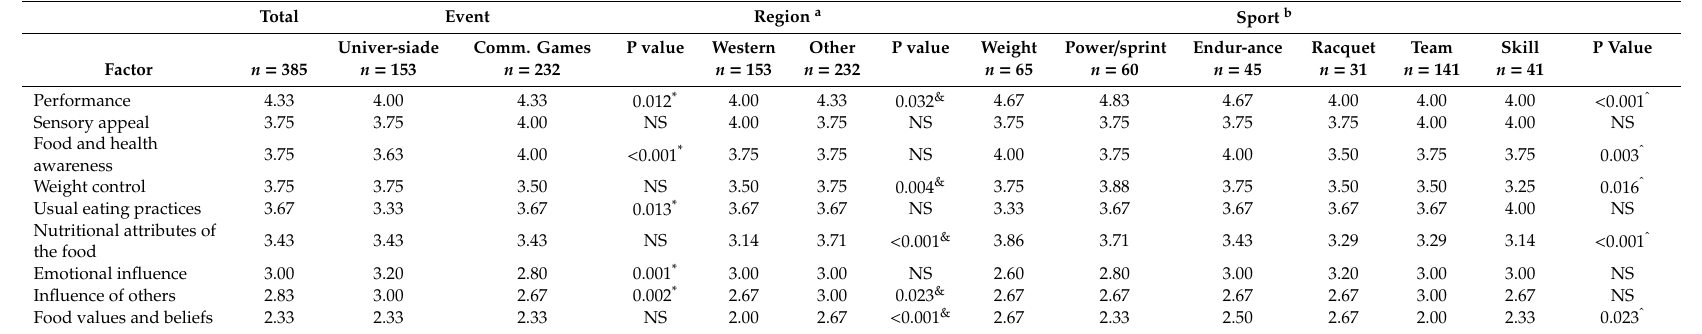
Table 2. Food choice factors median score for athletes ( n = 385) from event, region and sport